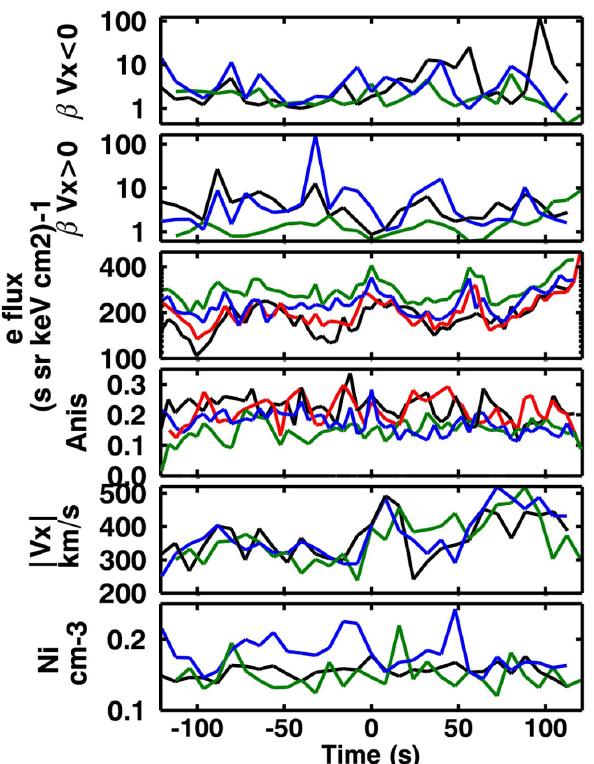
Fig. 5. Data from all spacecraft: SC1 – black, SC2 – red, SC3 – green and SC4 – blue. Average epoch presentation of plasma beta parameter for flux ropes on the tailward and earthward side of the X-line, the electron flux (cm − 2 (ssrkeV) − 1 ) of the 50keV energy channel measured by RAPID, the electron anisotropy for all elec- tron energies (field-aligned flux – perpendicular flux)/ (field-aligned flux + perpendicular flux), the V ion x (kms − 1 ), the electron density (cm − 3 ) calculated using the spacecraft potential (Pedersen et al., 2008) and the ion density (cm − 3 ). The X-axis time interval starts at 120s before the middle of the flux rope is observed (at zero seconds) and stops at 120s after.